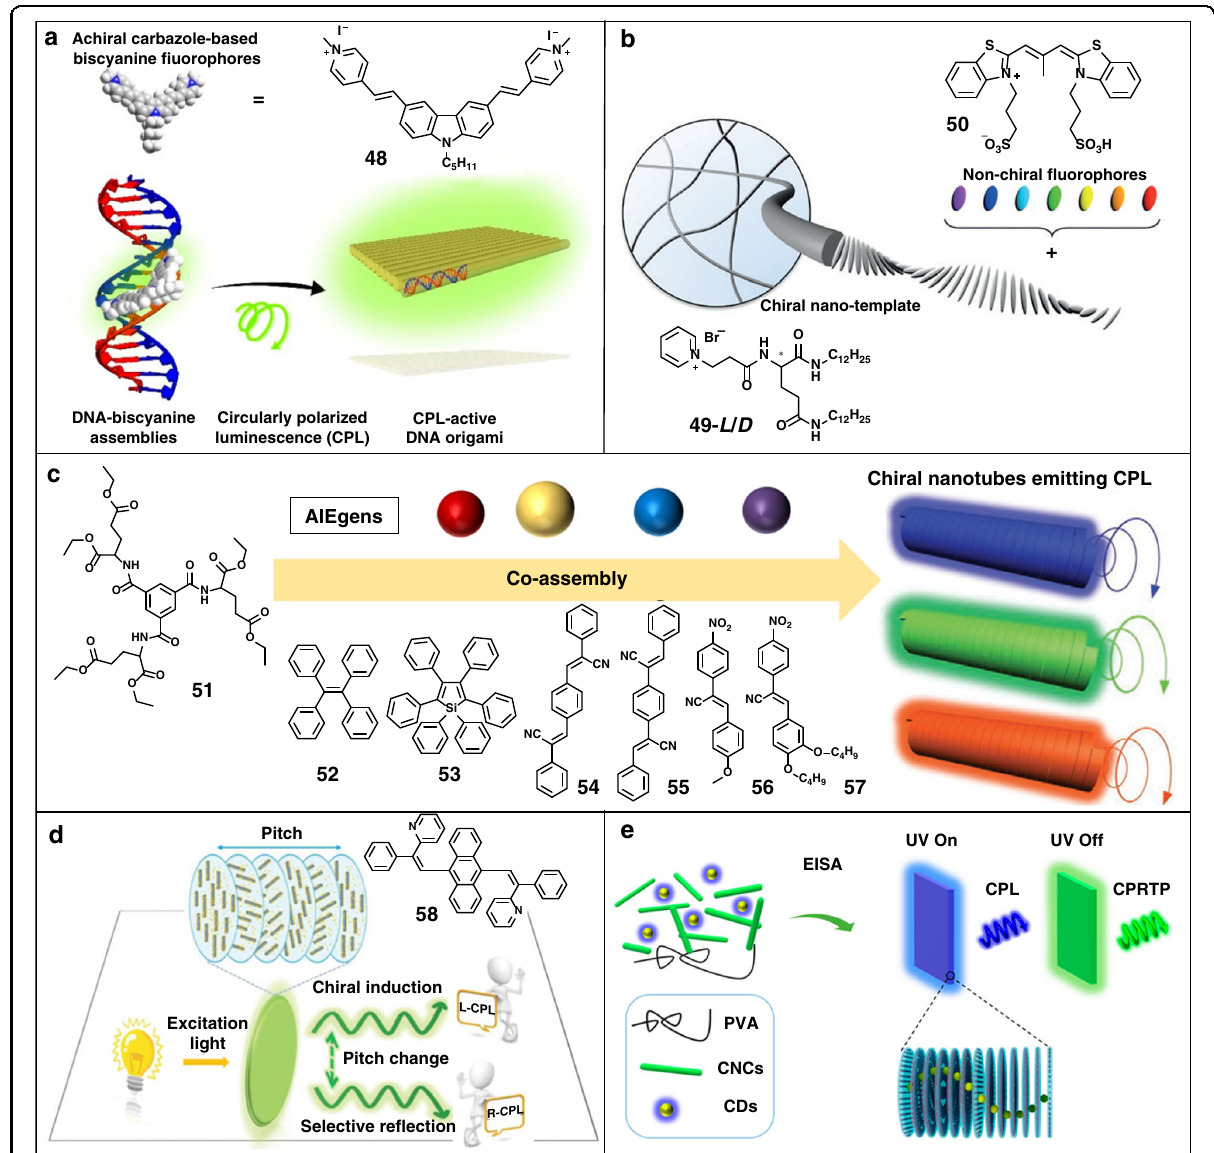
Fig. 6 CPL from the induced chirality of chiral nanotemplates. a Schematic illustration of DNA – biscyanine hybrid CPL-active materials. b Schematic illustration of induced CPL by encapsulating achiral dyes into chiral gelator. c Schematic illustration of induced CPL by encapsulating AIE dyes into chiral gelator. d Schematic illustrations of the selective re fl ection and chiral induction in CNCs. e Schematic illustrations of the generated CP-RTP. Image reprinted with permission from: a ref. 97 from ACS; b ref. 98 , c ref. 99 from Wiley; d ref. 102 from RSC; e ref. 103 from